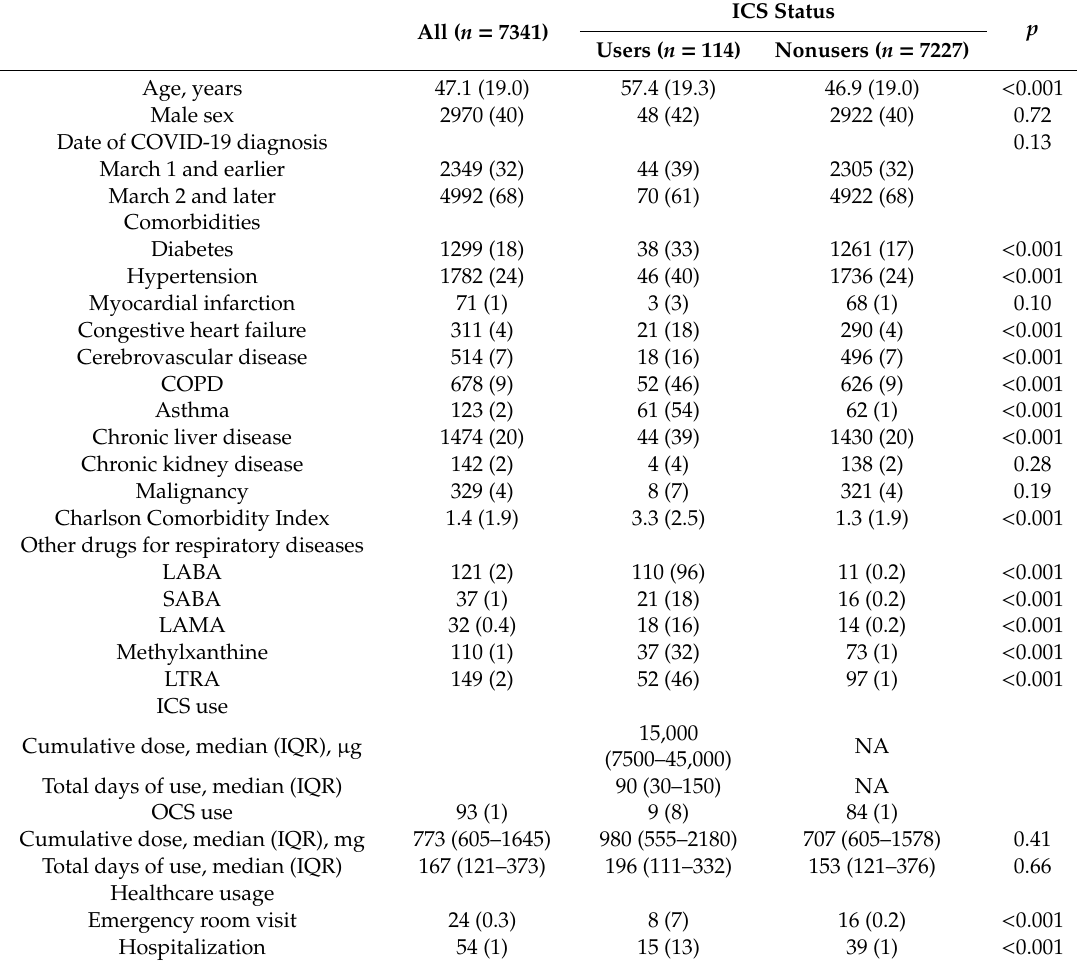
Table 1. Baseline characteristics of patients with COVID-19 according to ICS use.